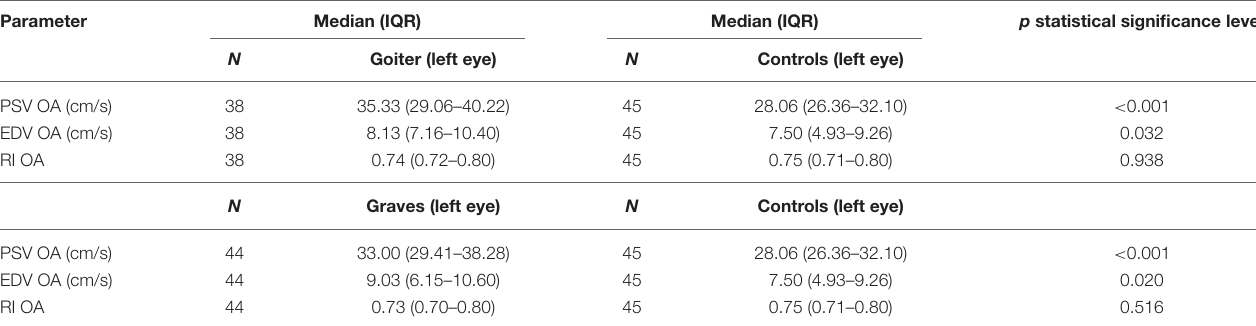
TABLE 7 | Comparison of blood flow parameters (PSV, EDV, RI) in ophthalmic artery in Graves’ disease, toxic nodular goiter, and healthy controls.